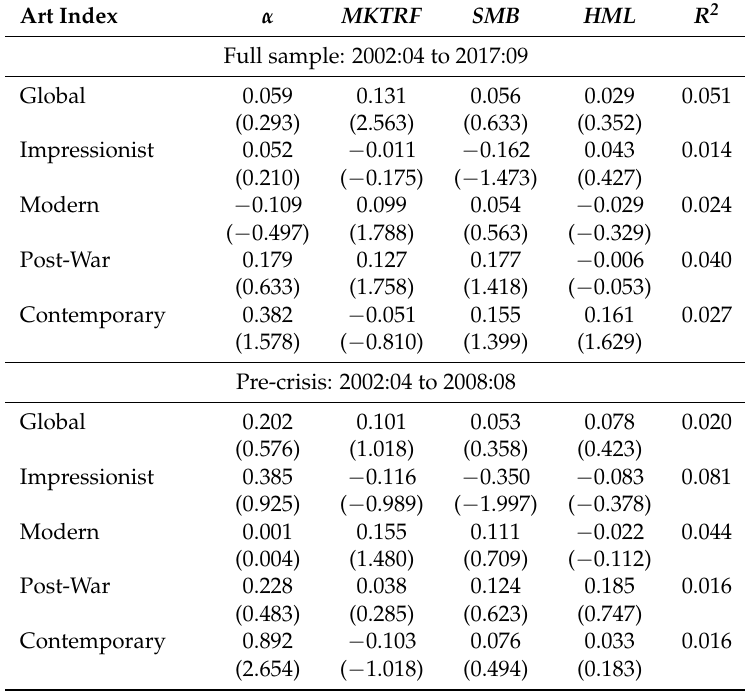
Table 4. The table reports the results of time-series regressions of the monthly returns associated with each art index on the three factors of Fama and French (1993). α is expressed as a percentage per month, and Newey–West t -statistics are reported in parentheses. Note that returns for the contemporary art index begin in